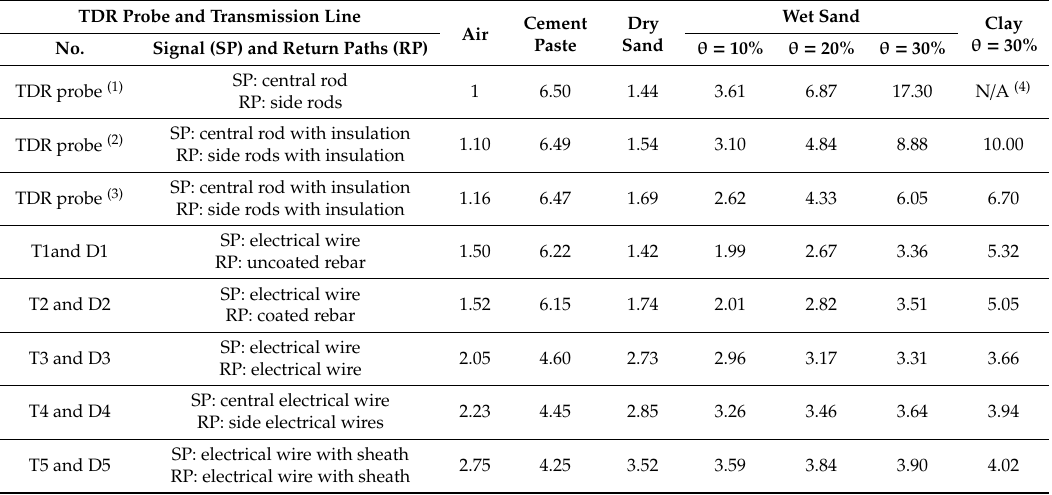
Table 1. Dielectric constants measured using a time domain reflectometer (TDR) probe without insulation and effective dielectric constants measured using TDR probes with polyvinyl chloride (PVC) insulation and transmission lines (T1 and D1–T5 and D5).